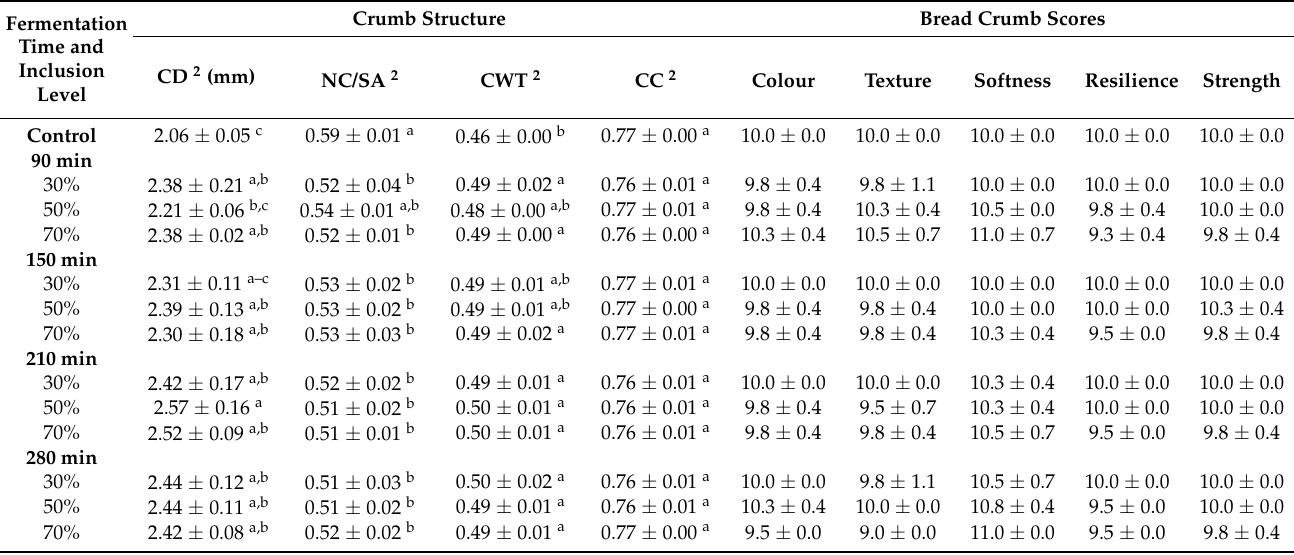
1 Different letters within the same column indicate significant differences for the results for each parameter at p < 0.05 (Tukey–Kramer test). 2 Abbreviations used: CD is cell diameter; NC/SA is number of cells per slice area; CWT is cell wall thickness; CC is cell